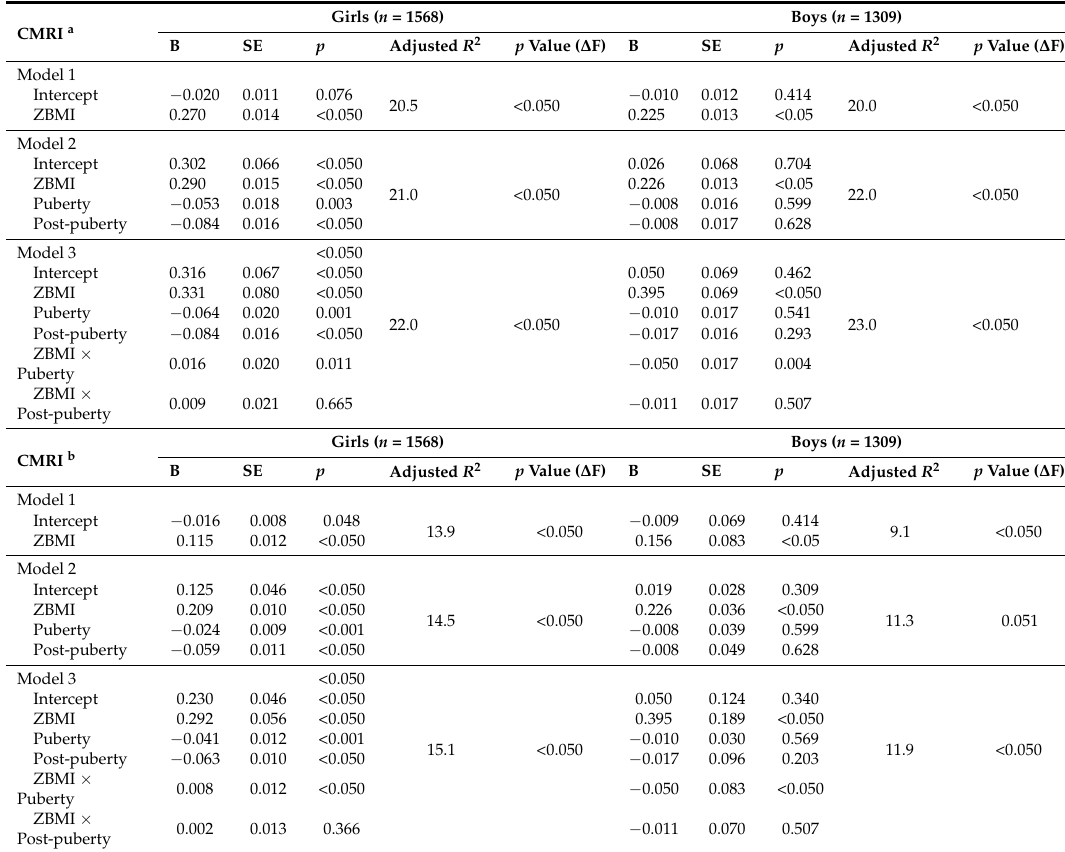
Table 3. Unstandardized regression coefficients examining the association of pubertal stage and cardiometabolic risk score adjusted by